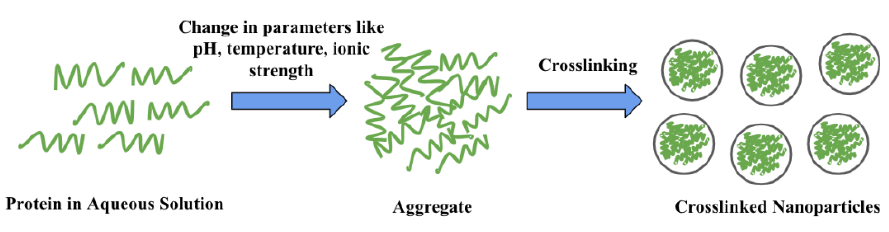
Figure 3. Phase Separation—Polymers are placed in an organic solvent and the addition of a surfac- tant to this aqueous solution takes place, to avoid the emulsion particle fusion. This solution is fur- ther put through ultrasonication, a method for mixing. Polymer droplets are formed and the solvent is isolated, concluded by the organic phase evaporation.